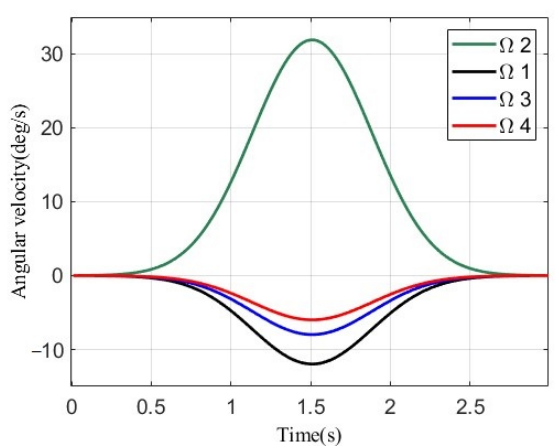
Figure 10. The angular velocities under the action of controller.